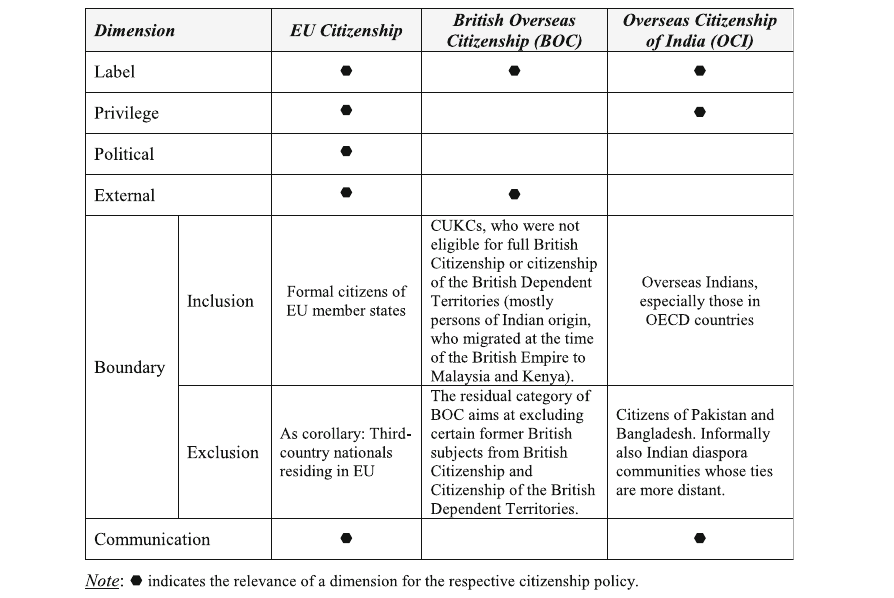
indicates the relevance of a dimension for the respective citizenship